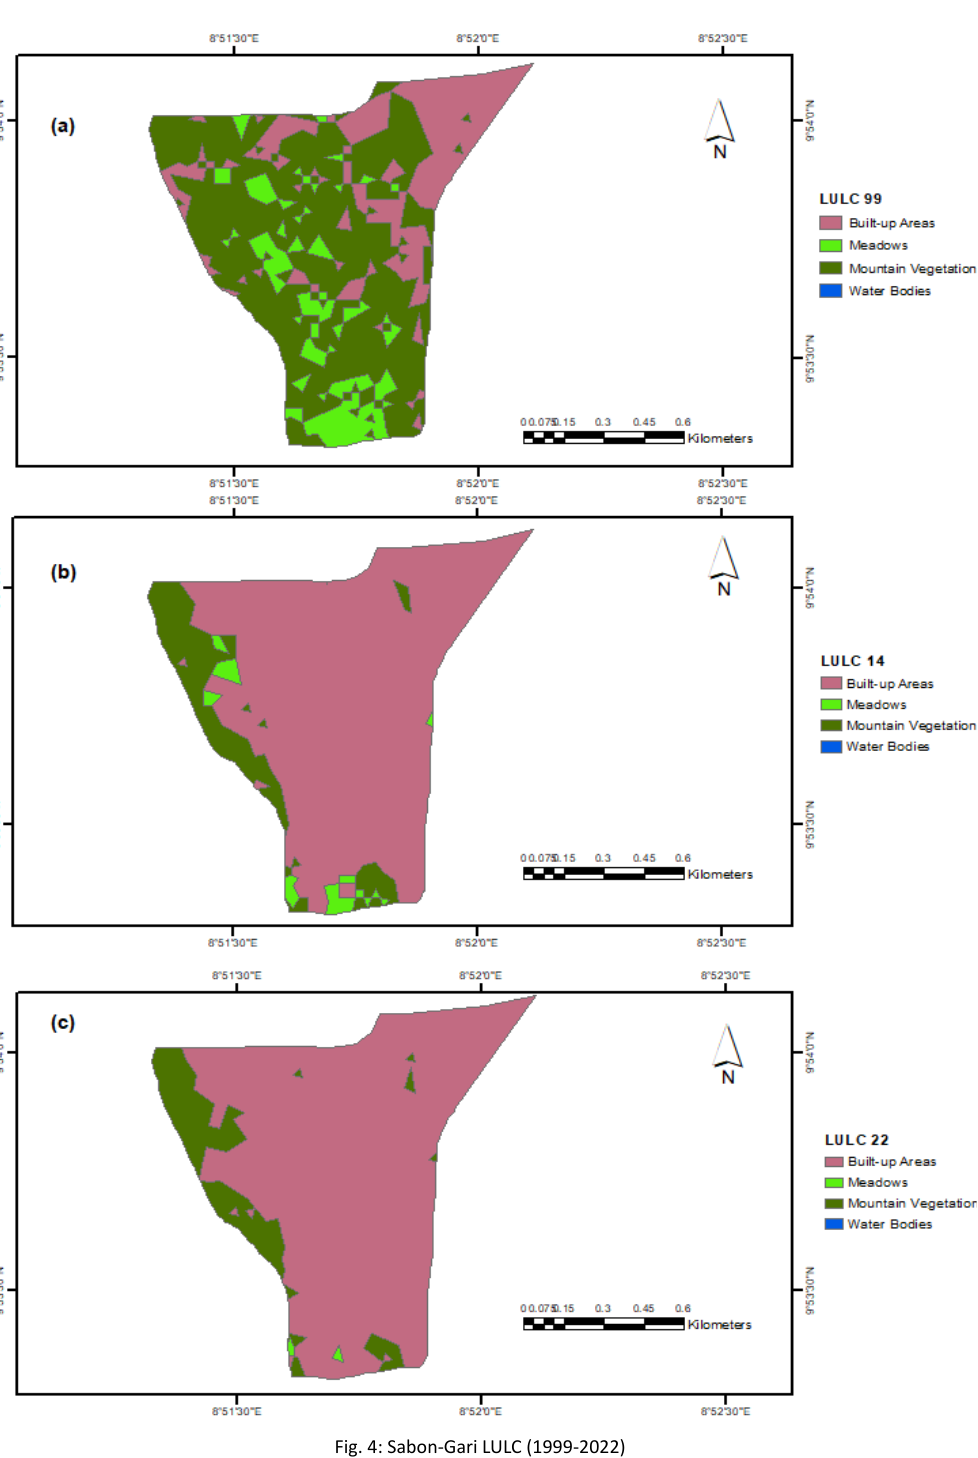
Fig. 4: Sabon‐Gari LULC (1999‐2022) Fig. 4: Sabon-Gari LULC